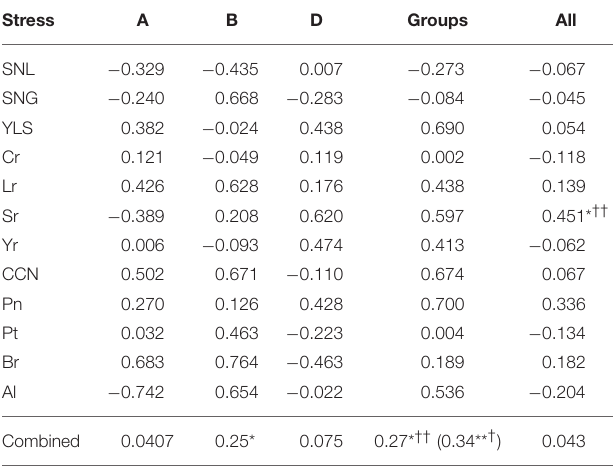
TABLE 2 | Pearson correlation coefficient ( r values) between the additive variance explained by all 21 chromosome sizes (column All), chromosomes within each subgenome (A, B, and D) and chromosomal group size